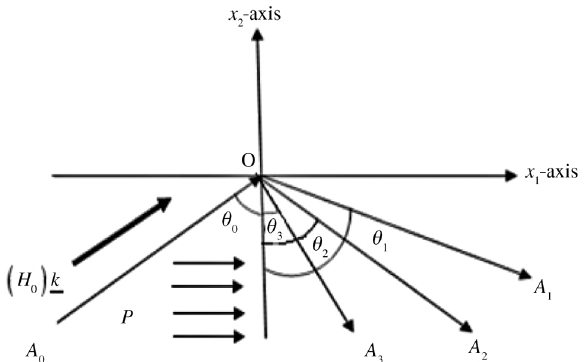
Figure 1: Schematic of the